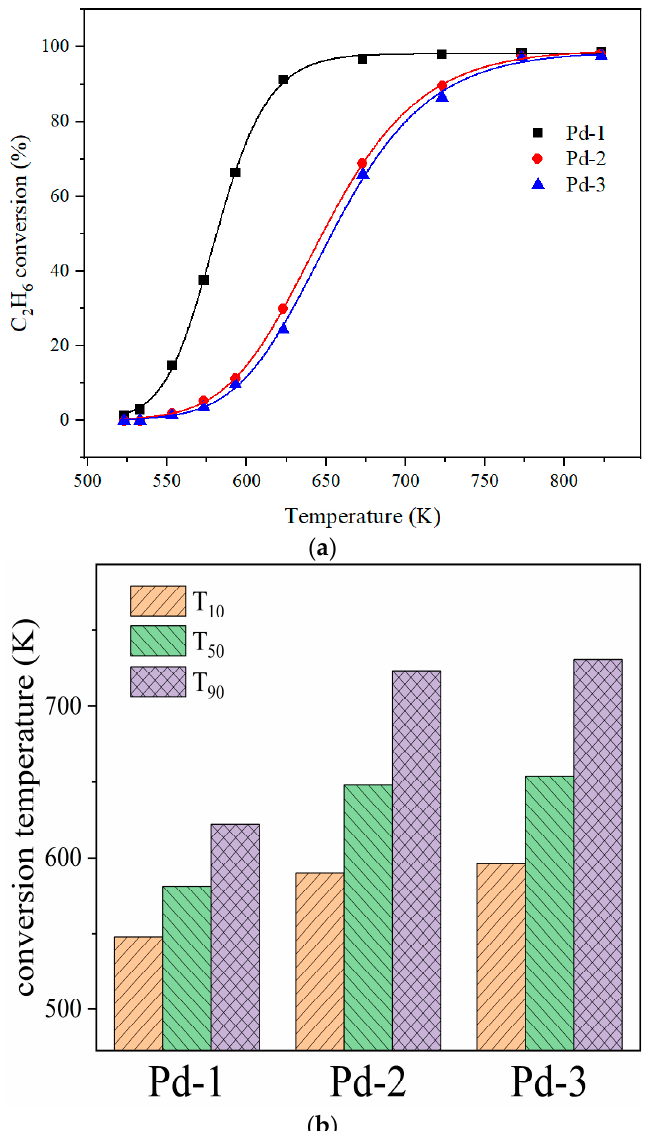
Figure 11. ( a ) Catalytic efficiency of Pd-1, Pd-2 and Pd-3 for ethane in the presence of water vapor. ( b ) T 10 , T 50 and T 90 of Pd-1, Pd-2 and Pd-3 for ethane in the presence of water vapor.